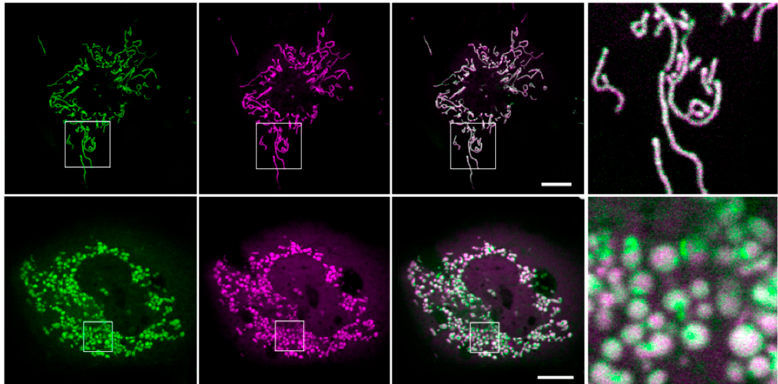
Figure 6. Active Kmpv 12T but not inactive Kesv alters the morphology of mitochondria. Confocal images of Cos7 cells expressing GFP-tagged Kesv (top) or Kmpv 12T (bottom). First column GFP (green), second column COXVIII::mCherry (purple), third column merge of purple and green channels. Area indicated by box is magnified in right column. Scale bars 10 μ m.